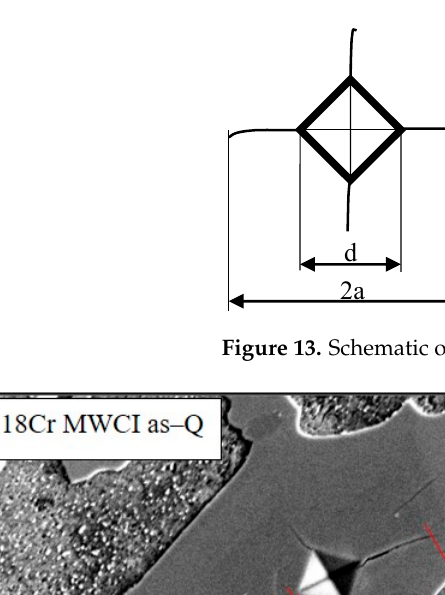
Figure 12. The M 7 C 3 carbide size distribution of high–Cr MWCI materials.